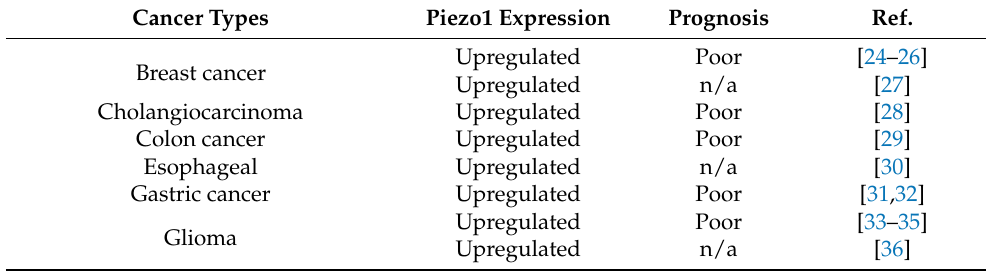
Table 1. Piezo1 expression in various cancers. Cancer